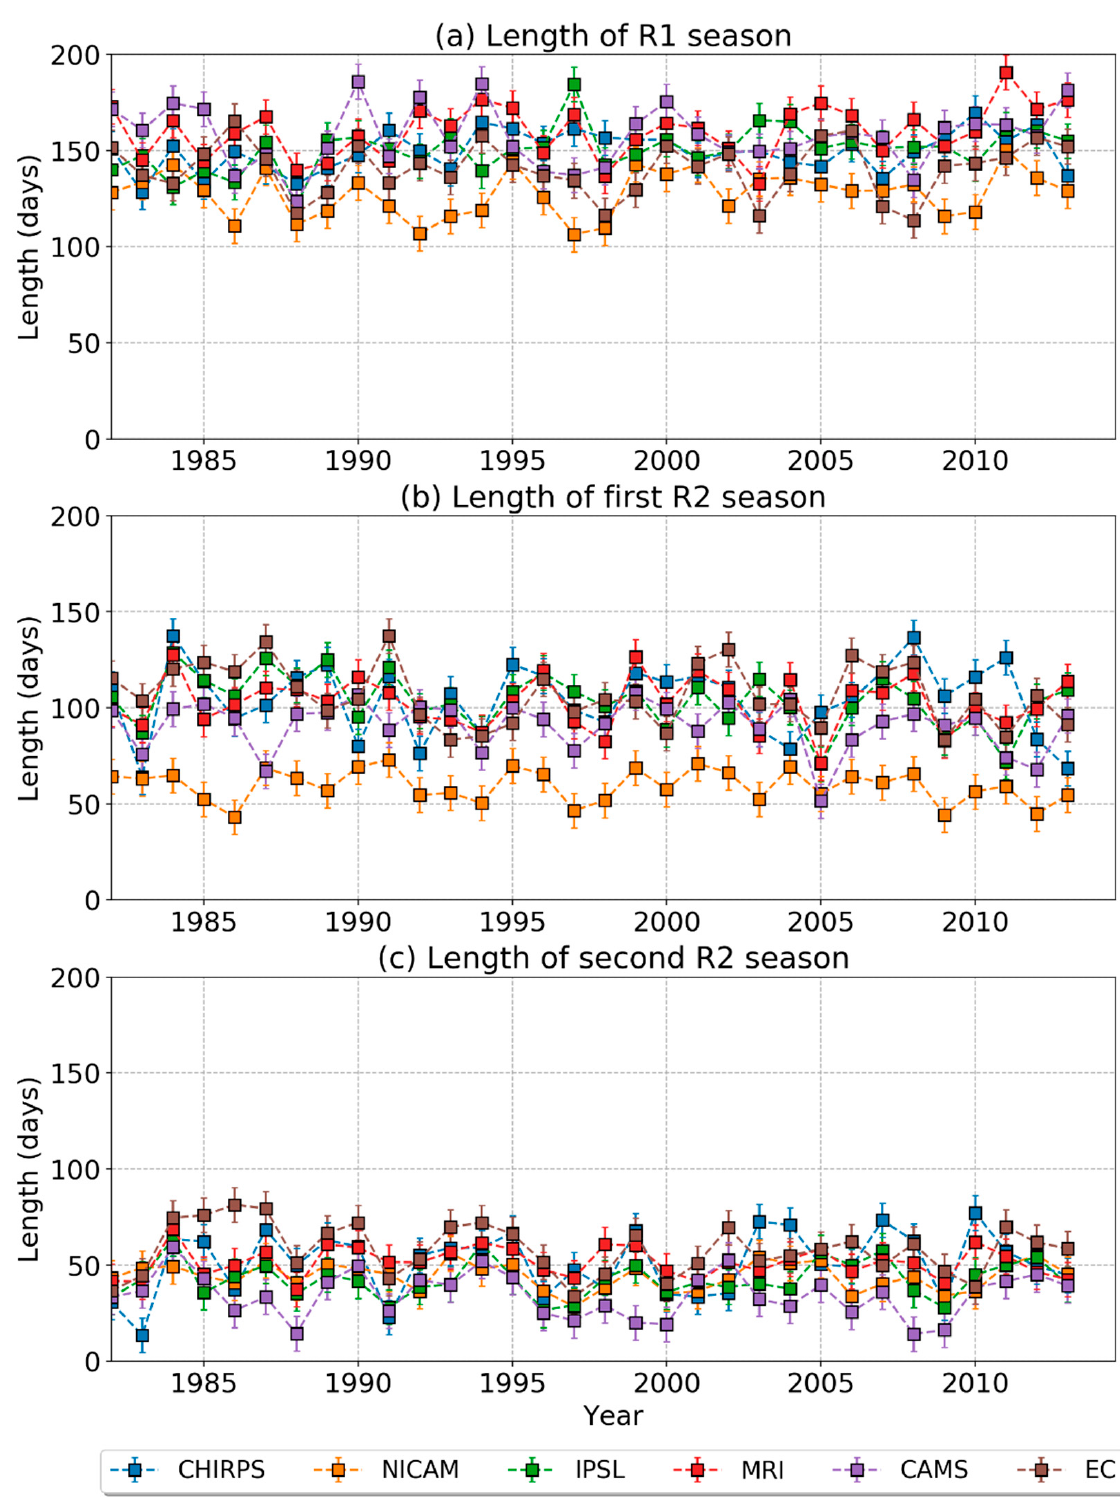
Figure 11. Time series of the length of the rainy season for ( a ) regions with annual rainfall, ( b ) first rainy season, and ( c ) second rainy season. Different coloured lines indicate different data sets. The error bars show the standard deviation in length of the rainy season across the region at each time.